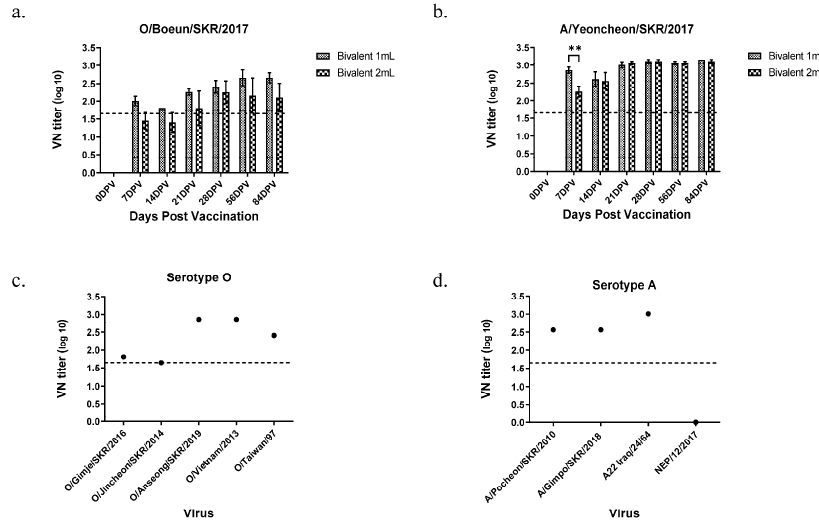
Figure 3. Virus neutralizing antibody titers against homologous and heterologous viruses in guinea pigs after immunization with the bivalent vaccine. Virus neutralization tests for O/Boeun/SKR/2017 ( a ) and A/Yeoncheon/SKR/2017 ( b ) were performed with sera collected from guinea pig vaccinated with two different volumes (1 mL and 2 mL) of the bivalent vaccine until 84 days post-vaccination (dpv). ( c ) Virus neutralization test for the serotype O heterologous viruses was performed with sera collected 28 dpv from guinea pig vaccinated with 1 mL of the bivalent vaccine. ( d ) Virus neutralization test for the serotype A heterologous virus was performed with sera collected 28 dpv from guinea pig vaccinated with 1 mL of the bivalent vaccine. The dotted line represents 1:45 (1.65 log 10 ) of virus neutralizing antibody titer that is regarded to be positive according to the OIE terrestrial manual. The data shown are representative of three independent experiments and are presented as the mean ± SD values. The asterisks represent the statistical differences: **, p < 0.005.